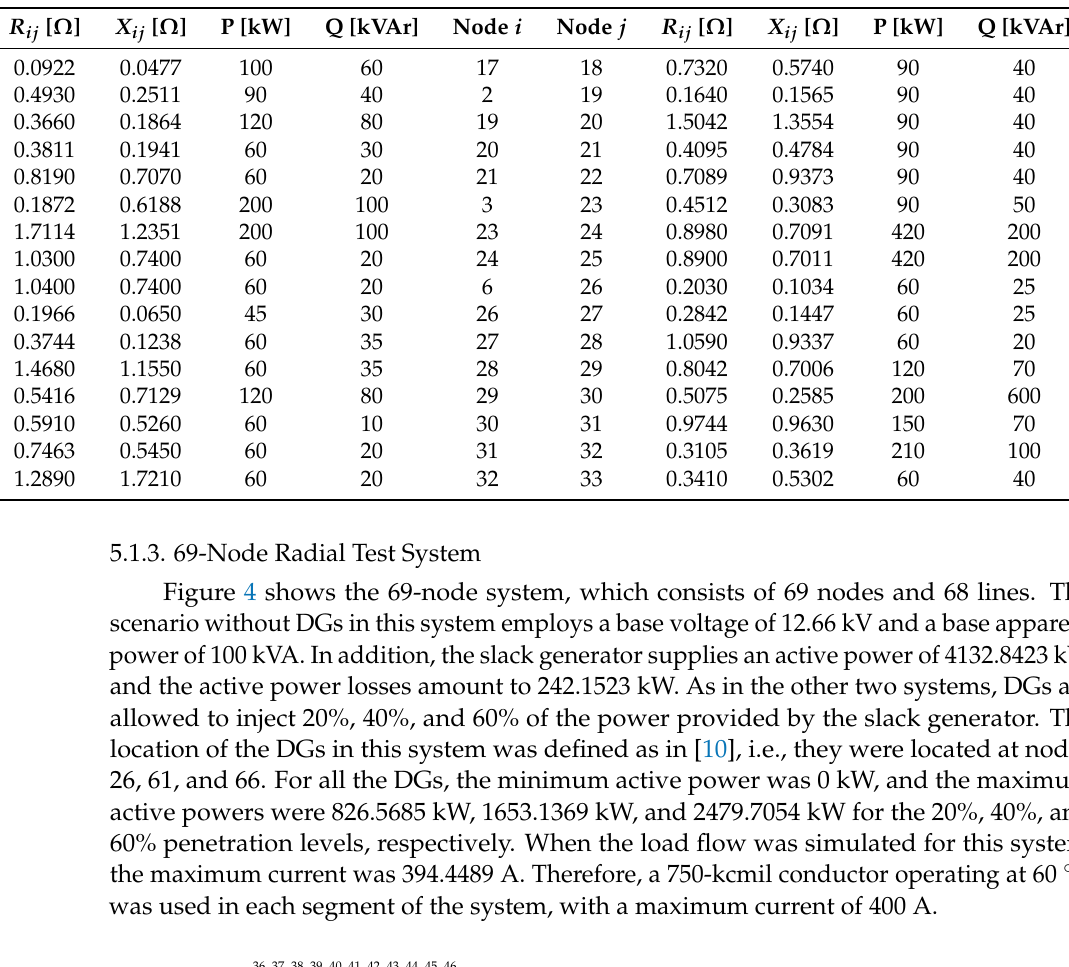
Figure 3. Electrical configuration of the 33-node radial test system. Table 4, which is organized in the same way as Table 3, reports the electrical parameters of the 33-node system. Table 4. Electrical parameters of the 33-node radial test system.